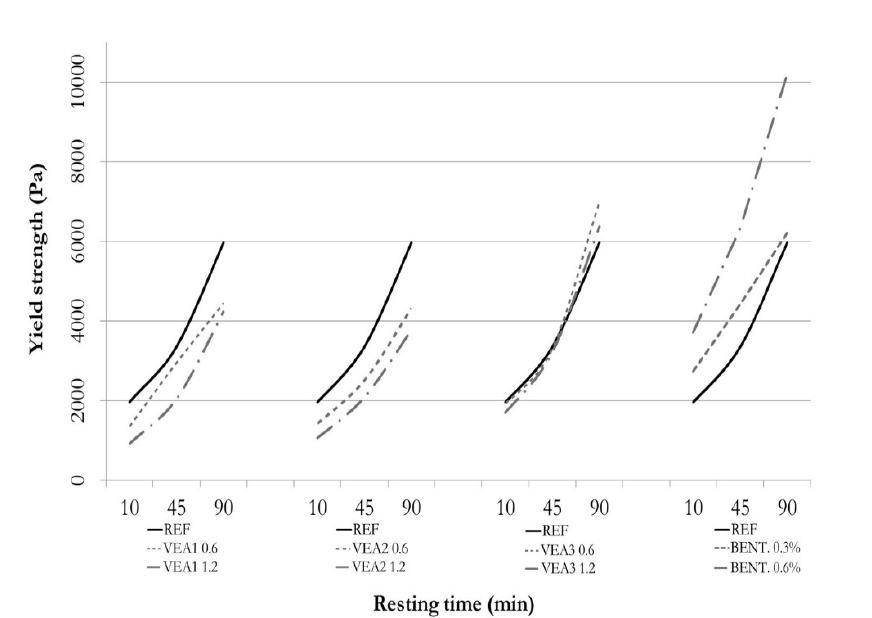
Figure 4. Yield strength evolution over